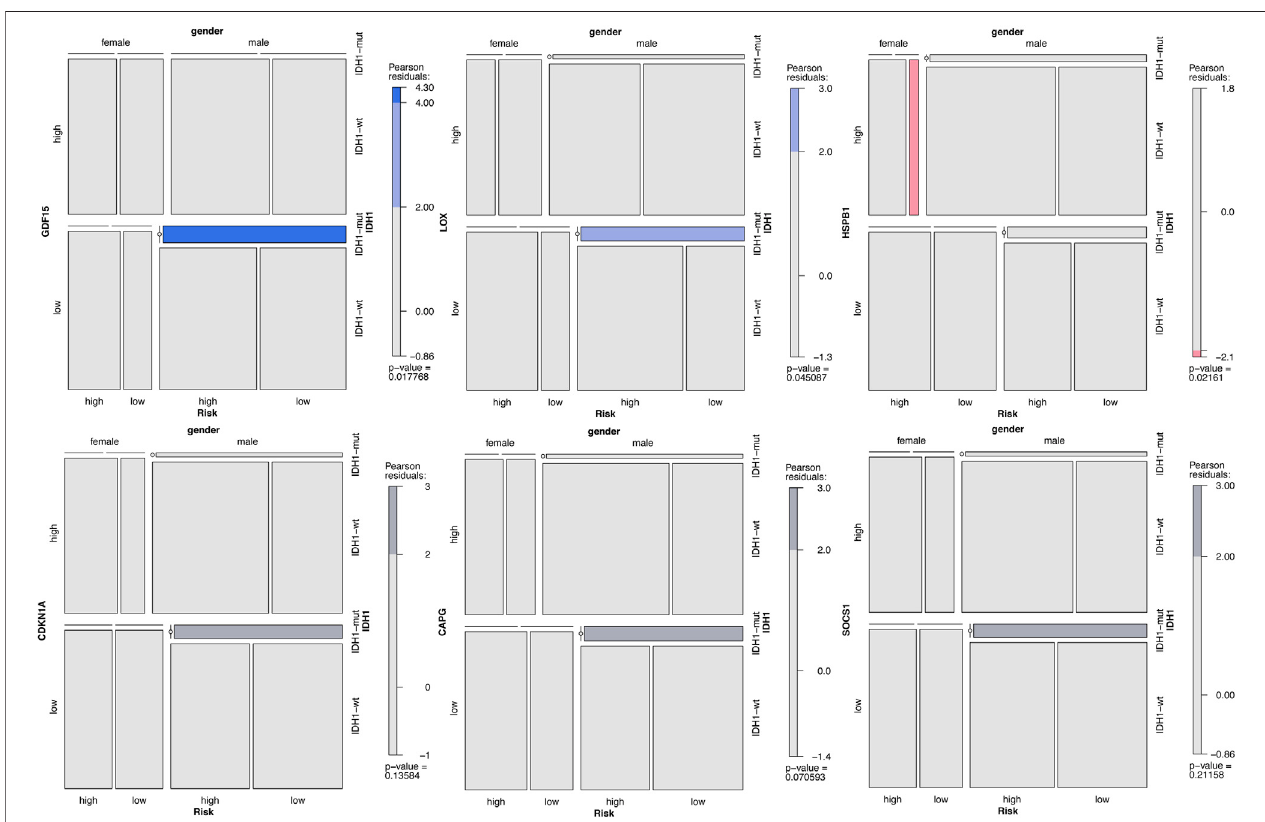
FIGURE 13 | Correlation analysis between the key genes and the GBM clinical characteristics. Note: The darker the color is, the stronger the correlation is. Blue indicates positive correlation, red expresses negative correlation, and grey has a weaker correlation.